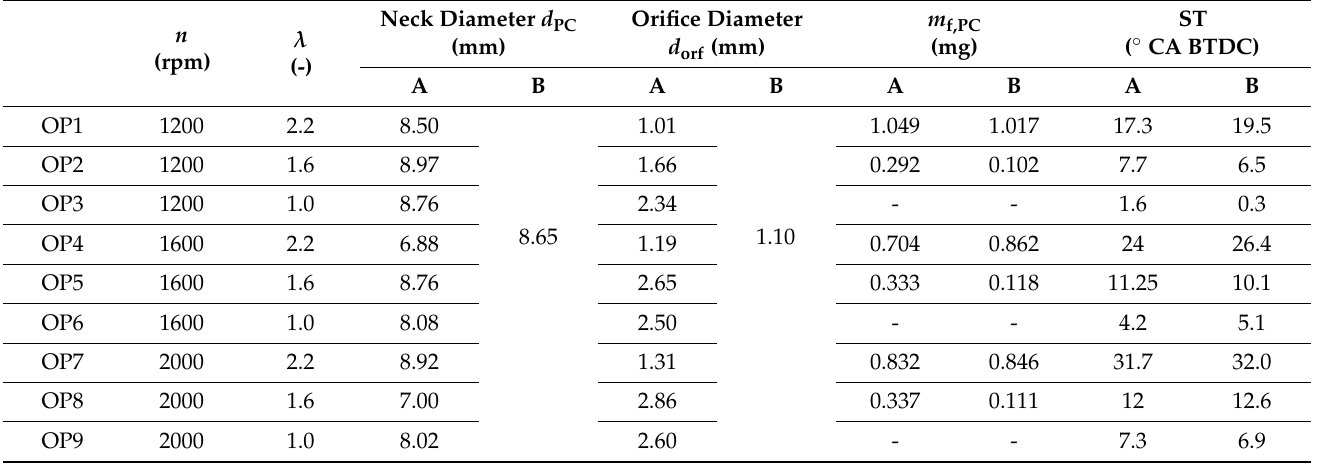
Table 6. Overview of optimization results for individual (A) and simultaneous (B) optimization of pre-chamber geometry and operating